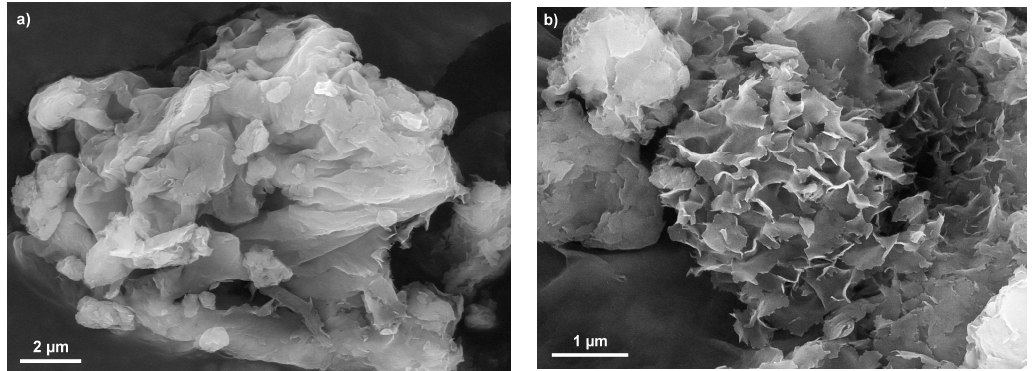
Figure 5. ESEM images ( a ) distribution of micro aggregates in the raw material; and ( b ) typical fluffy smectite morphology of the particles in the clay fraction.